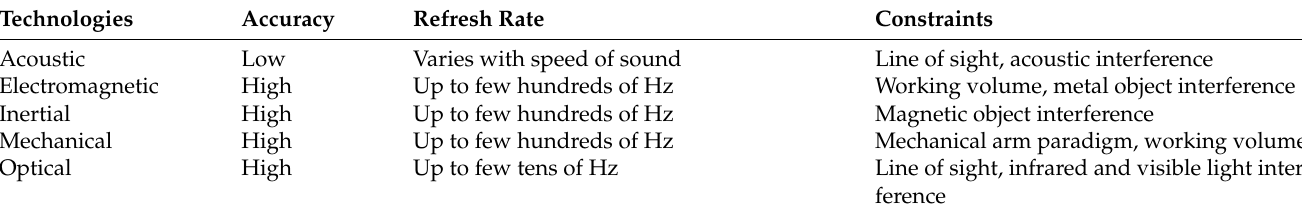
Table 1. Summary of motion-tracking technologies.